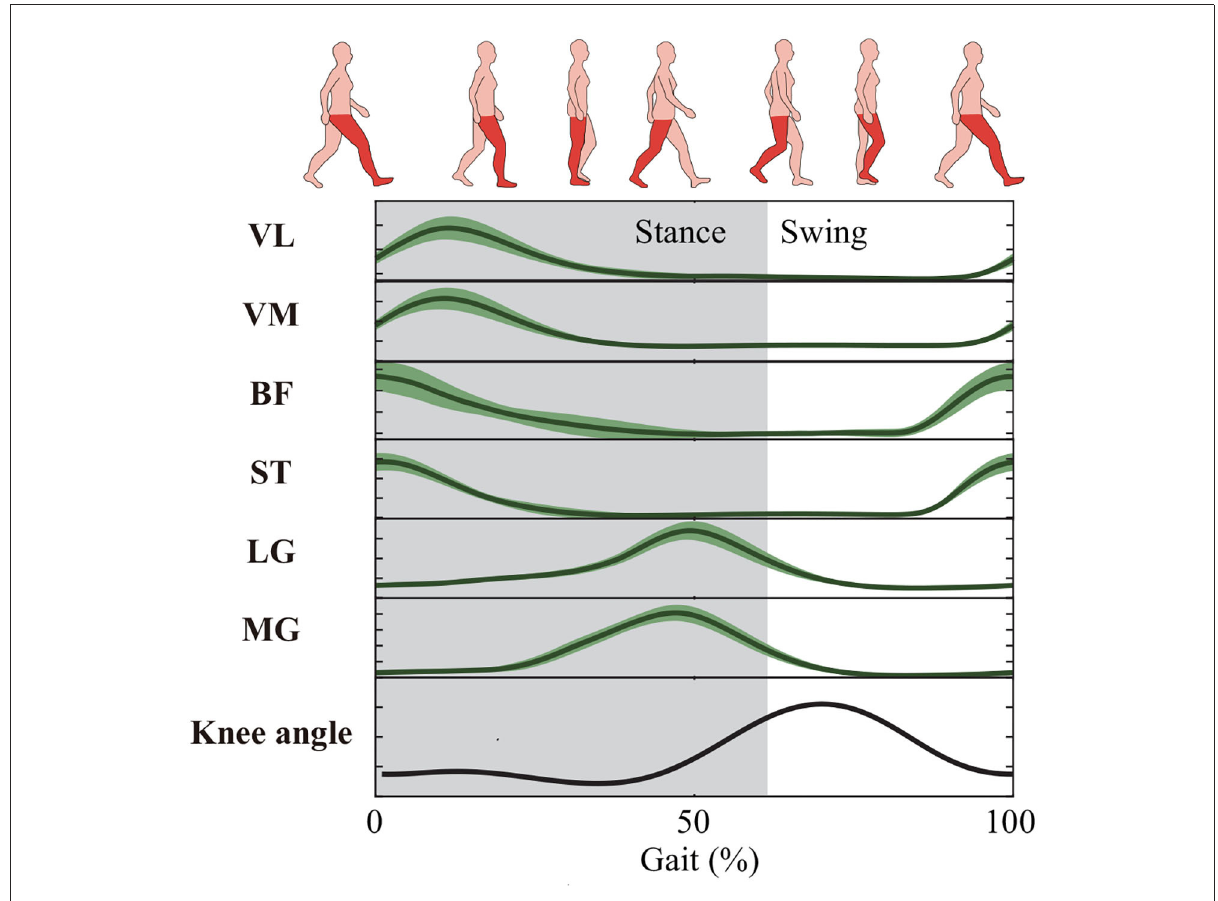
FIGURE7 Muscle activity profiles and knee angle profiles during the gait cycle.